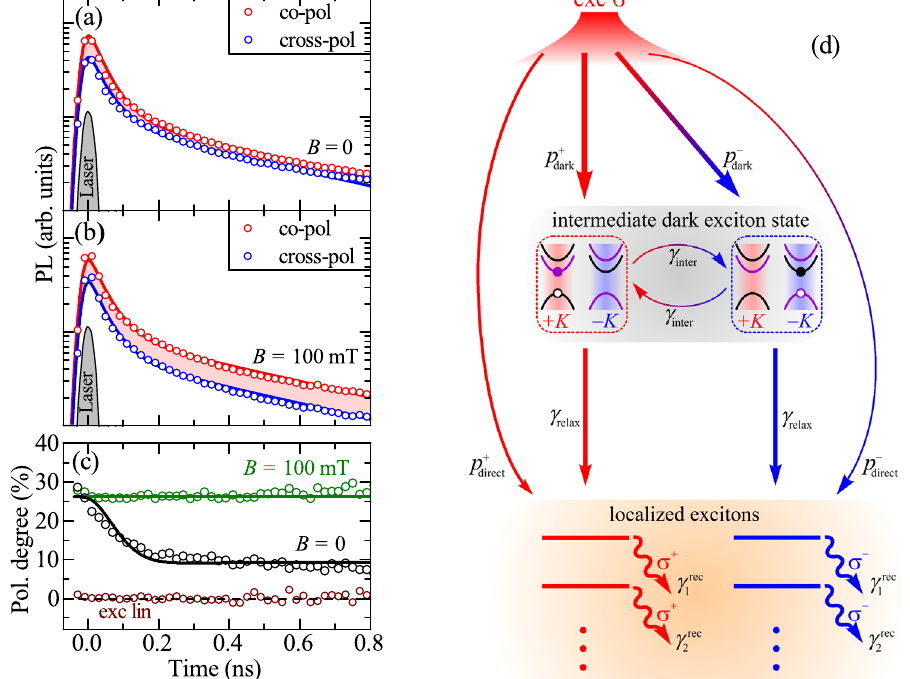
FIG. 3. (a,b) Time-resolved PL of the localized excitons integrated over the emission energy ranging from E ¼ 1635 meV to E ¼ 1710 meV. The temporal profiles were measured under the σ þ polarized pulsed excitation at E ¼ 1915 meV in two circular polarizations of detection and for two values of the magnetic field: B ¼ 0 (a) and B ¼ 100 mT (b). The instrument response profile measured using a backscattered laser is shown for reference. (c) The circular polarization degree of the localized excitons emission measured under circularly polarized excitation as a function of time after the laser pulse for B ¼ 0 and B ¼ 100 mT. The temporal profile of the circular polarization degree showing no observable polarization under linearly polarized excitation is displayed for comparison. The solid lines in (a – c) represent the fit to the experimental data with the rate-equation model described in the text. (d) A scheme of the states and transitions included in the rate-equation model (a quantitative description of the model, together with the list of parameters used, is provided in Ref. [28]). The horizontal lines indicate the states, while the arrows mark the transitions. The color indicates the valley polarization (red: σ þ ; blue: σ −